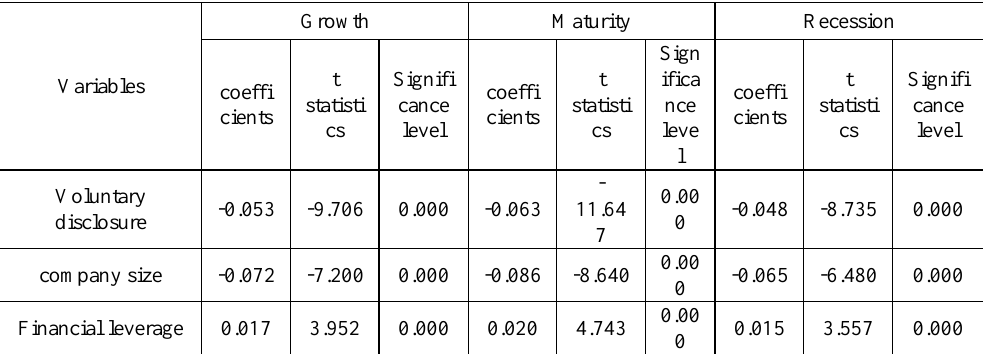
Table 3. Results of the voluntary disclosure hypothesis test and the company's earnings management criteria over the life